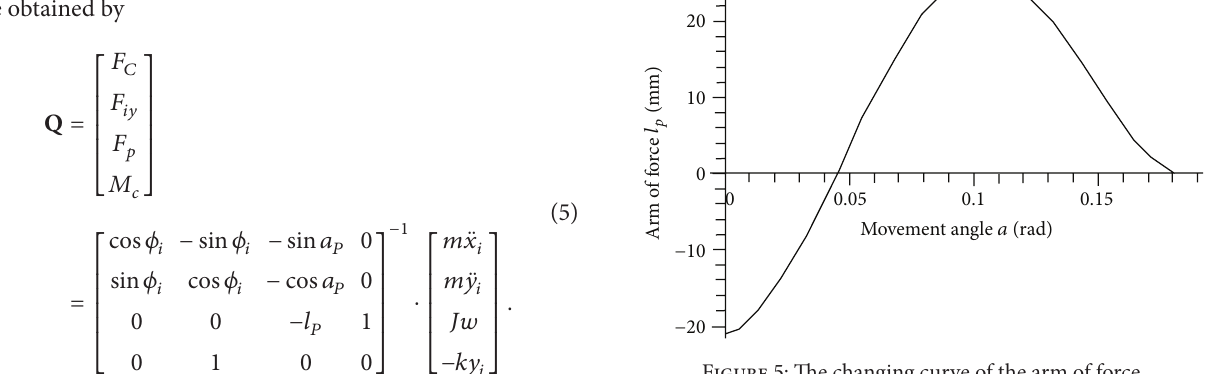
Figure 5: The changing curve of the arm of force.